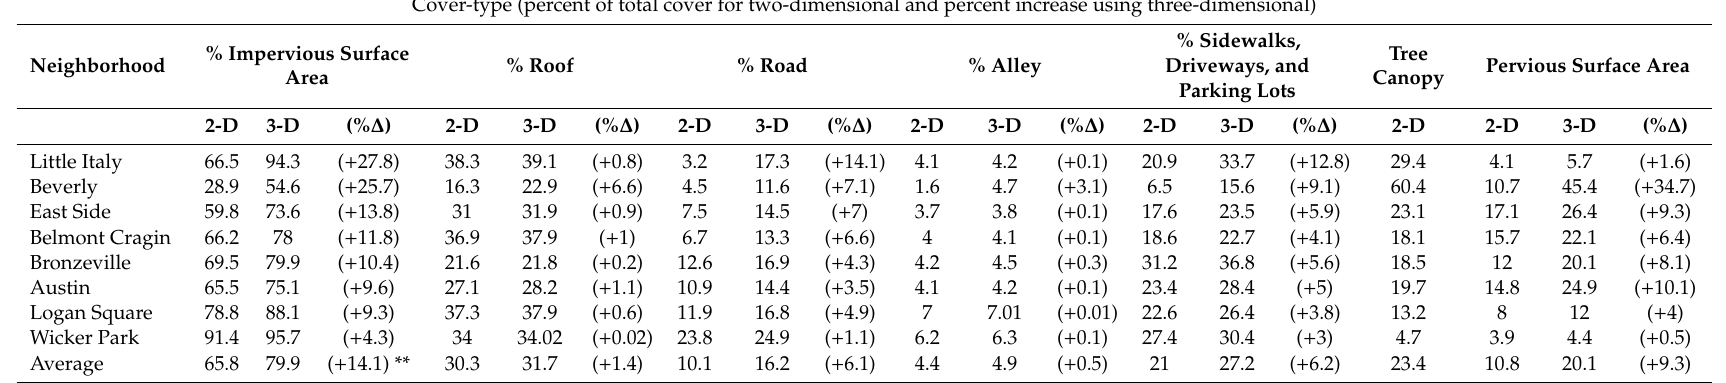
Table 6. Descriptive statistics of two (2-D) and three-dimensional (3-D) characterization of land cover variables in 2010 for eight